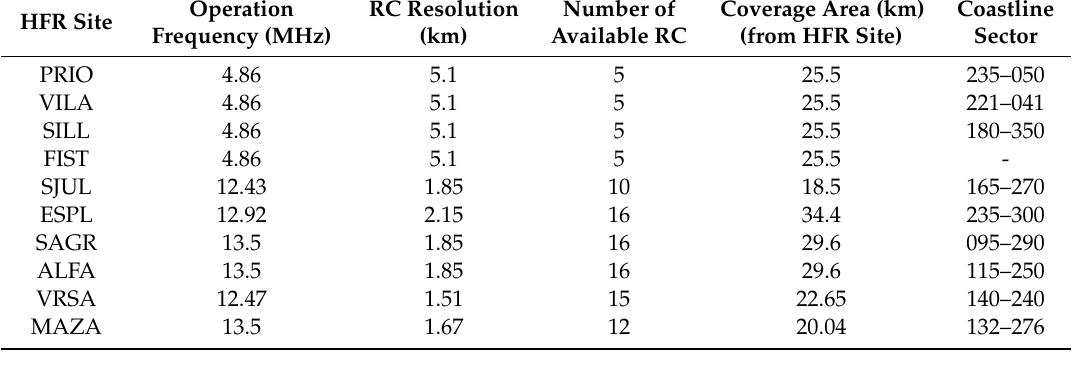
Table 2. HFR sites information regarding wave data acquisition. Standard information of each HFR: Operation frequency, range cells (RC) resolution, number of available RC, coverage area and coastline sector.